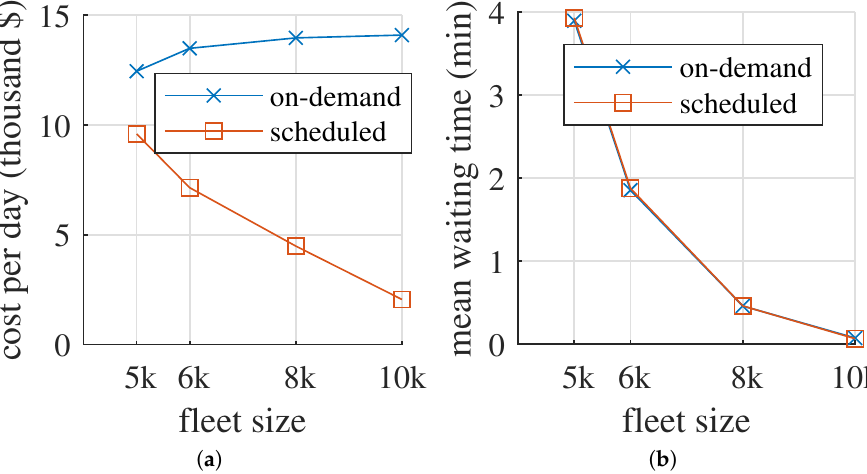
Figure 13. Effects of fleet size on: ( a ) average charging costs and ( b ) mean waiting times for different charging